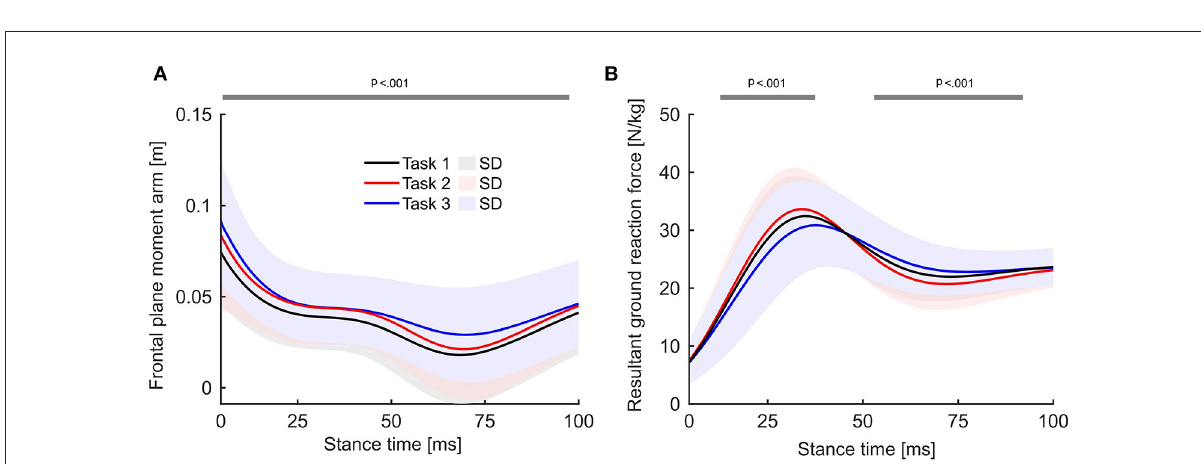
FIGURE5 (A) Time continuum of the frontal plane moment arm of the knee joint from initial ground contact to 100ms after ground contact for the three task complexities. (B) Time continuum of the resultant ground reaction force for the three task complexities. The gray lines above the graph indicate significant differences over the respective time